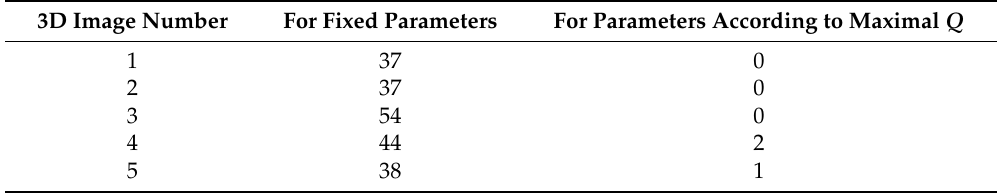
Figure 15. Slices of segmented image: ( a ) fixed parameters; ( b ) parameters by maximization of Q . Table 1. The number of erroneously segmented particles.